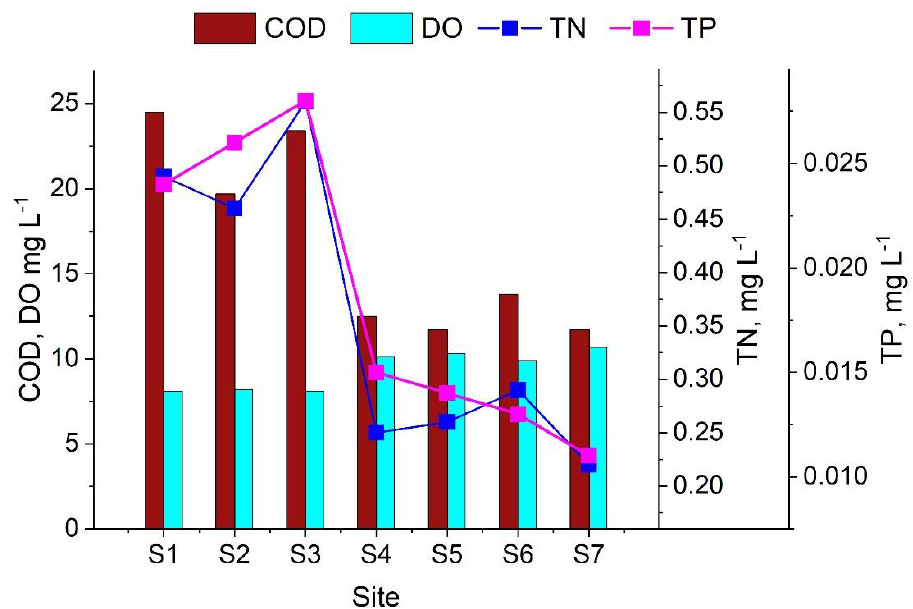
Figure 4. The varying concentrations of dissolved oxygen, chemical oxygen demand, total nitrogen, and total phosphorus at the sampling sites in the summer of 2016.